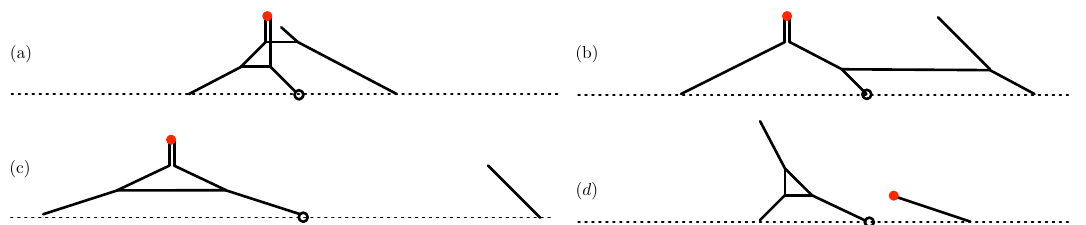
Figure 17. (a) A 5-brane web for SU( N ) 4 − N A non-perturbative Higgsing. (c) 5-brane web for P 2 ∪ F 6 ∪ F 8 ∪ · · · ∪ F 2 N + “1 Sym ” which is rank of N − 2 .